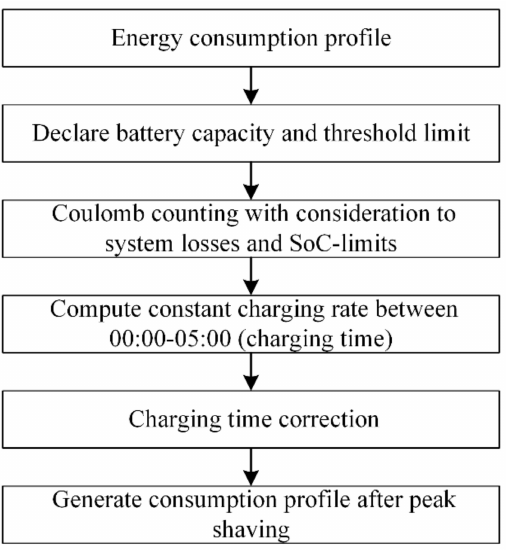
Figure A1. The simplified block-diagram for the